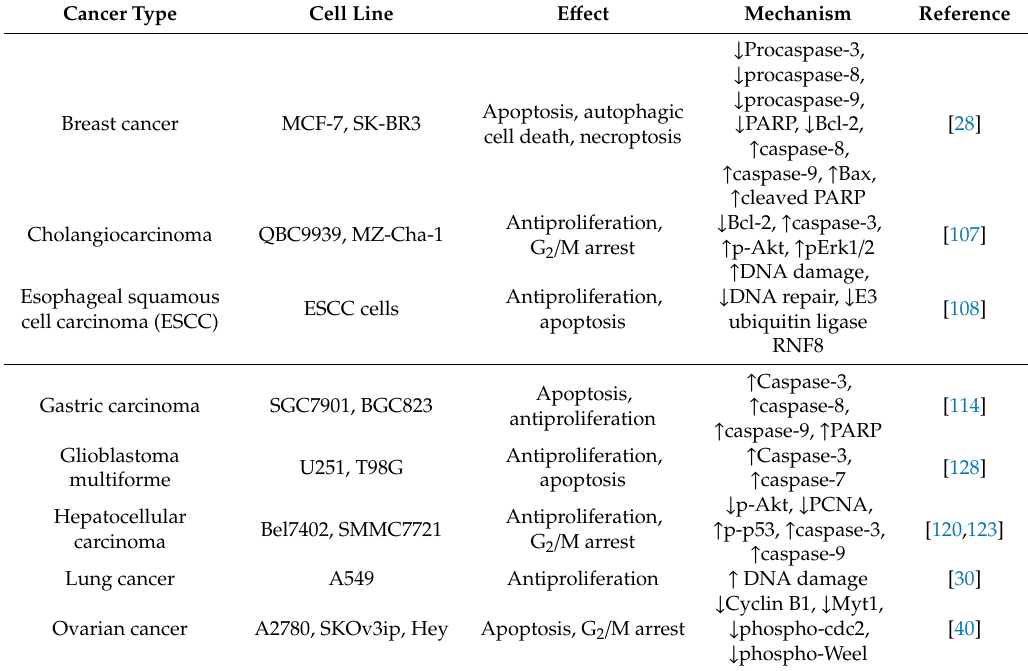
Table 2. In vitro anticancer e ff ects of corilagin on various cancer cell